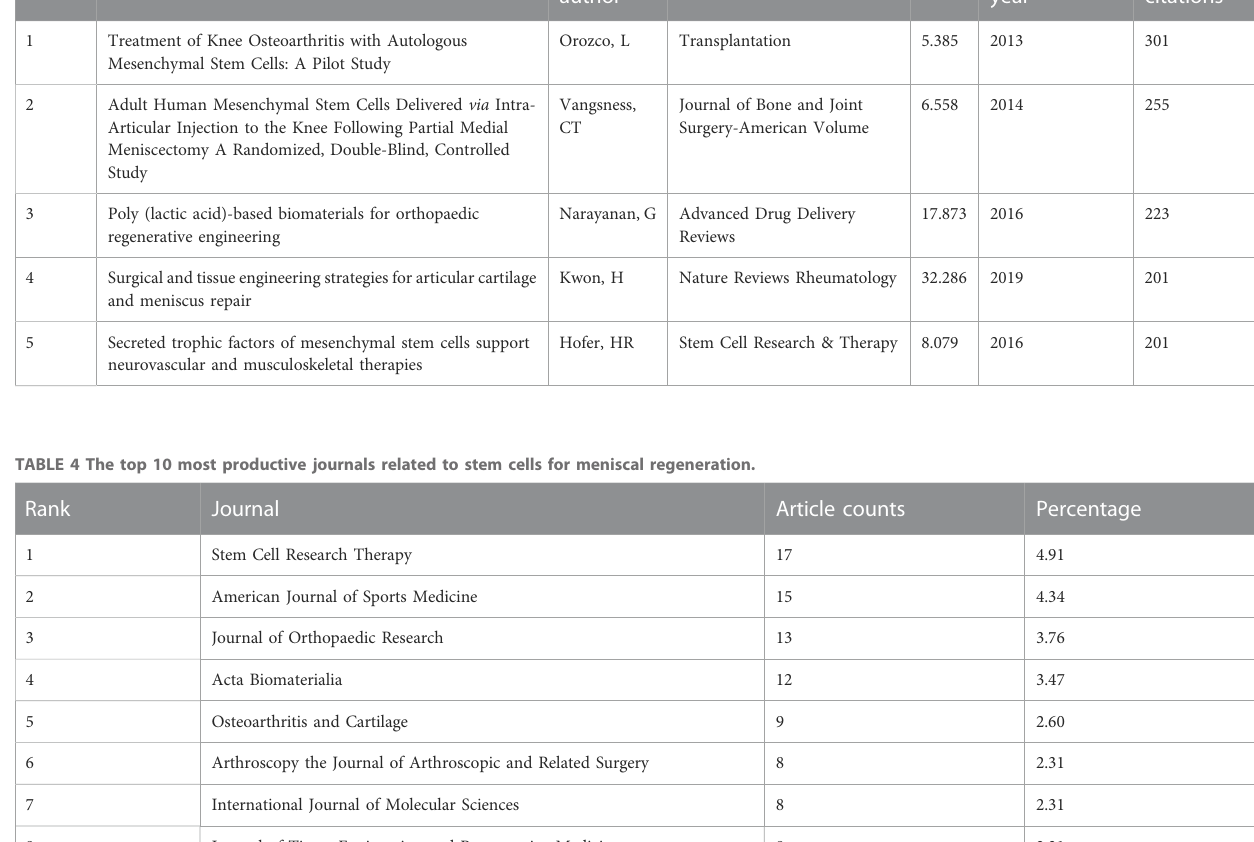
TABLE 3 The top 5 documents with the most citations in the fi eld of stem cells for meniscal regeneration. Rank